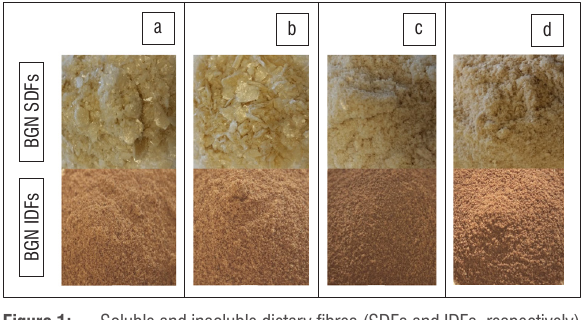
Figure 1: Soluble and insoluble dietary fibres (SDFs and IDFs, respectively) isolated from four varieties of Bambara groundnut (BGN): (a) black-eye, (b) brown-eye, (c) brown and (d) red.